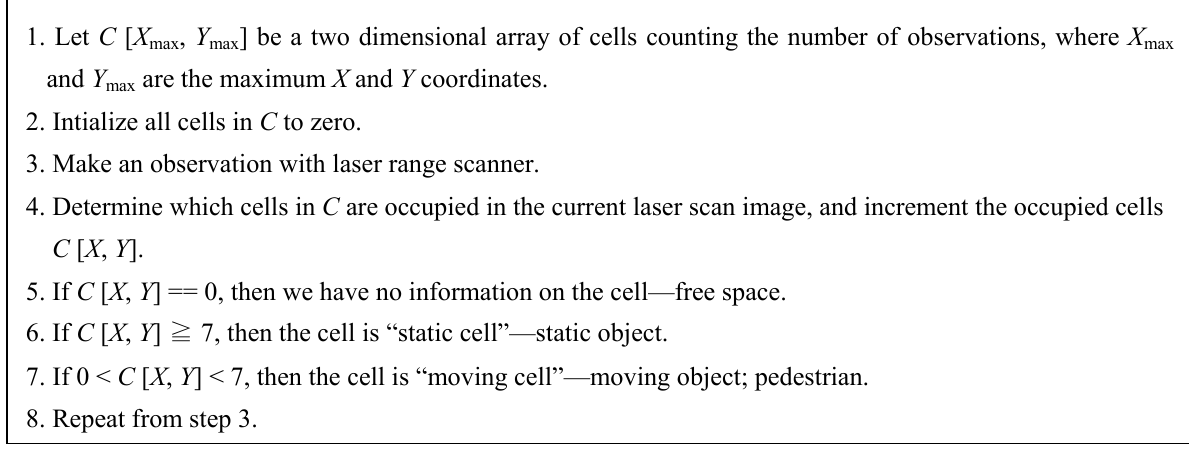
Figure 3. Tracking mode; robots #1 and #2 track a pedestrian in cooperative tracking mode, and robot #3 tracks a pedestrian in individual tracking mode. The red arc indicates the LRS sensing